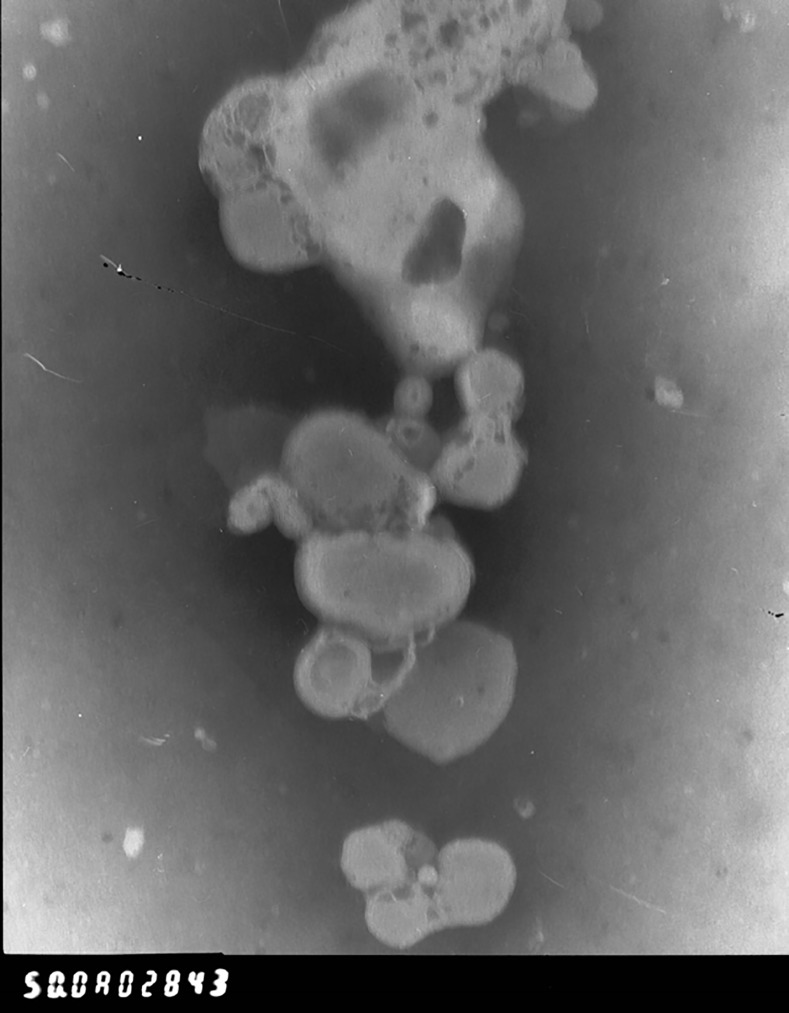
Transmission electron images of silymarin loaded liposomes (5×1000 times).